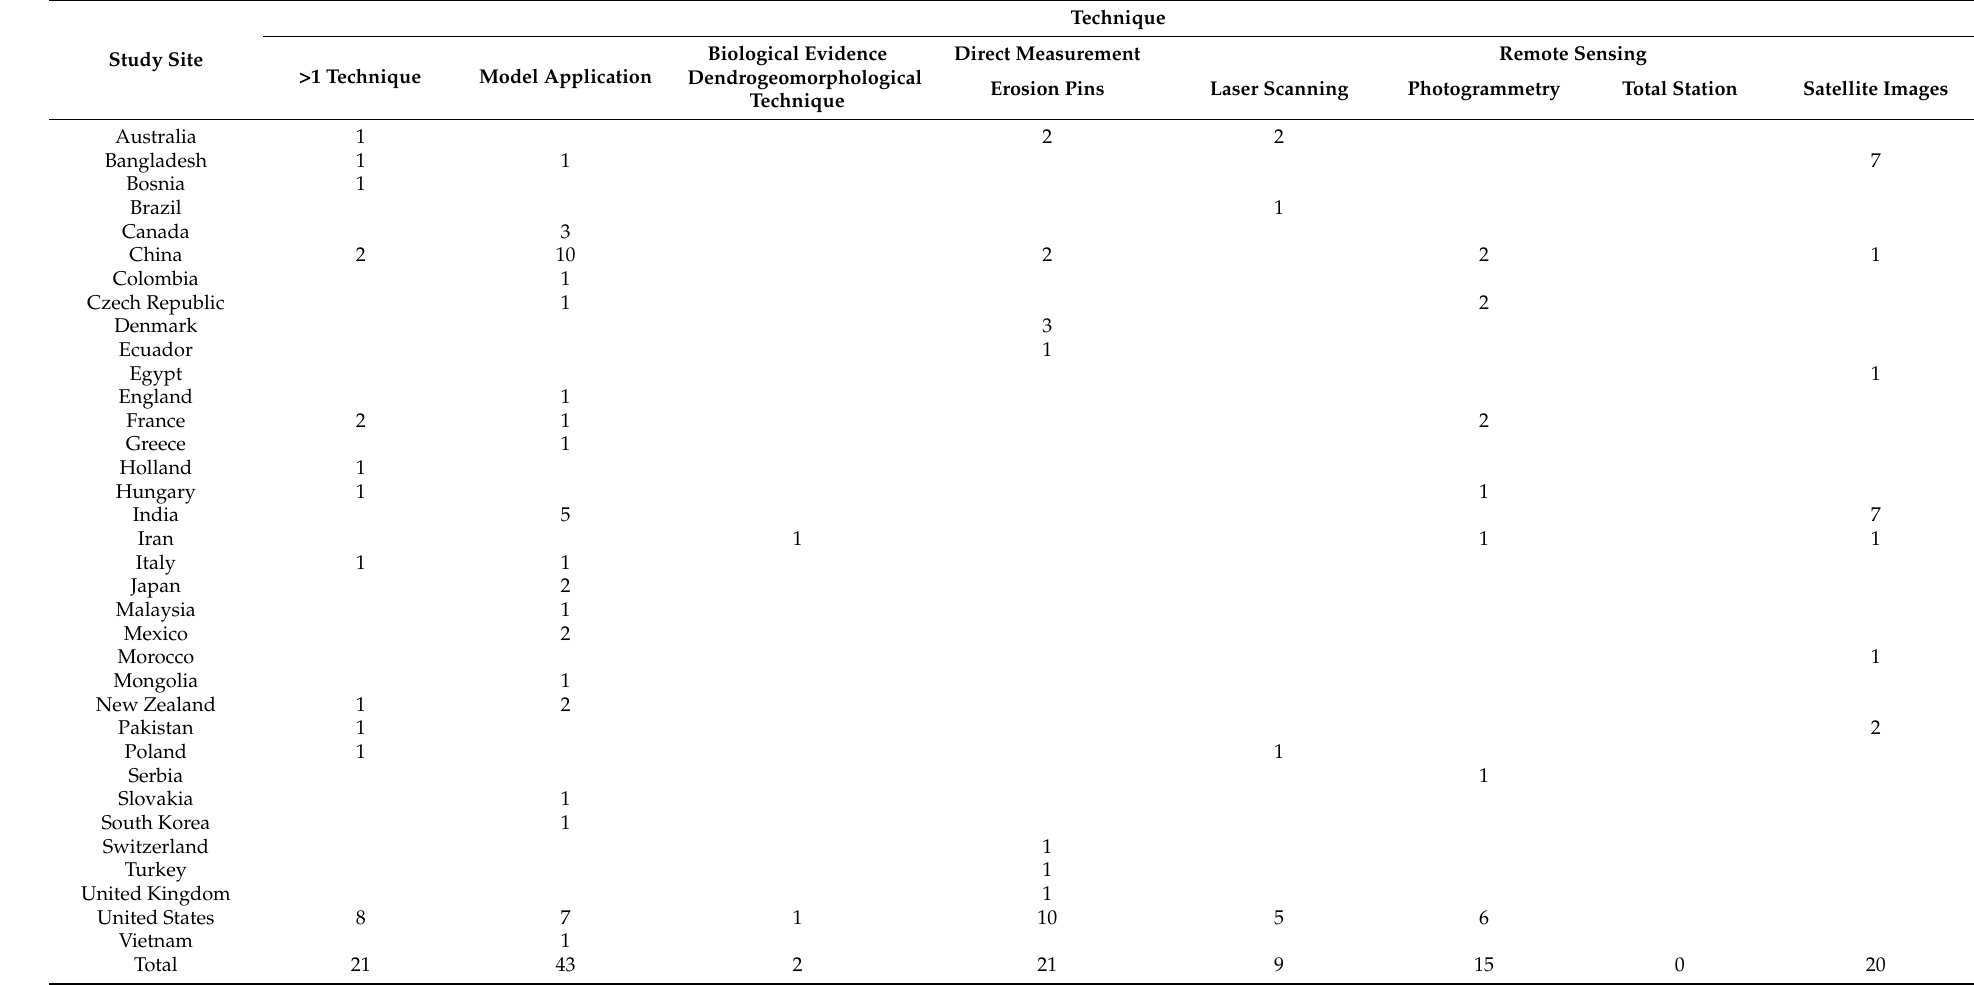
Table 2. Study locations and techniques used for measuring erosion in